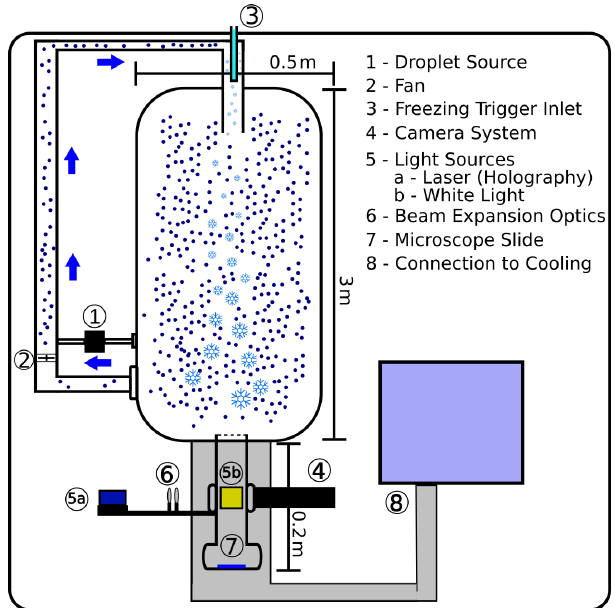
Figure 1. Schematic (not to scale) of the ICC from a side view. Droplets are generated and introduced into the chamber from an ul- trasonic nebulizer (1) and mixed throughout the chamber through circulation created by a fan (2). After the desired cloud conditions are reached, freezing can be triggered in the top region using a cold finger (3). The measurement section (4–7), where mass and fall ve- locity measurements are conducted, is suspended below the cham- ber and ventilated with air from a cooling unit (8) to improve static stability.